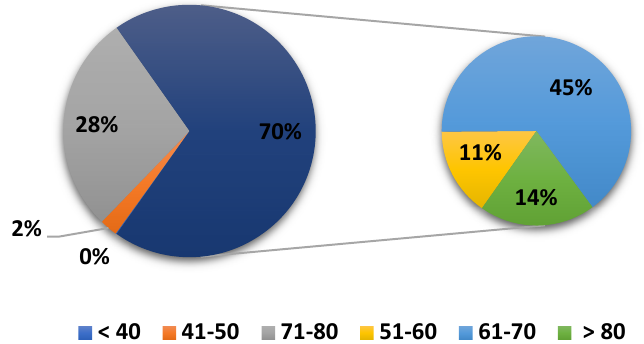
Figure 2. Distribution of N-COV batch I by age bracket.